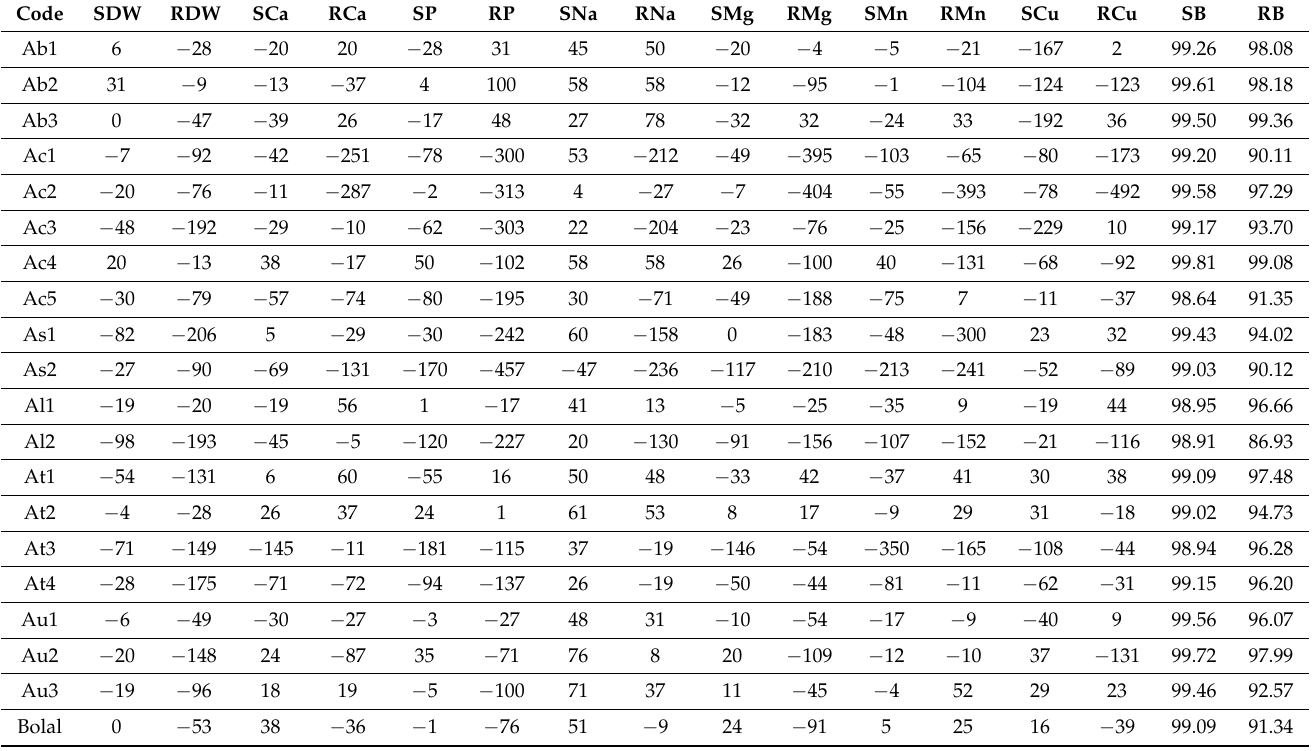
Table 3. The percentage changes in the uptake of all the studied elements in 19 Aegilops genotypes